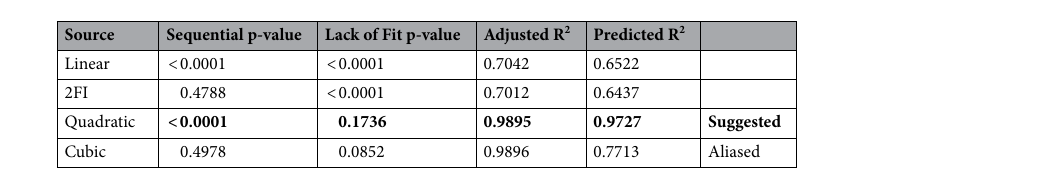
Table 4. Fit Summary models of AR18 removal. Significant values are in